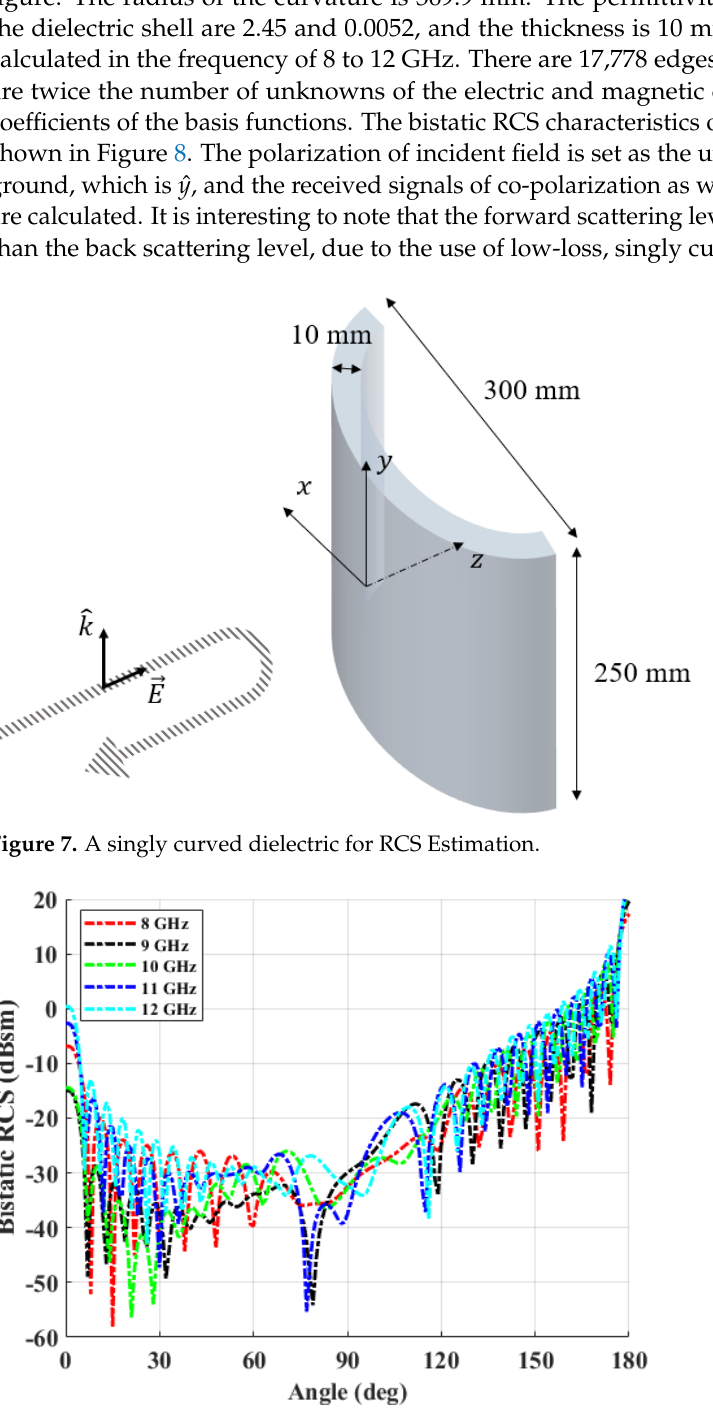
Figure 8. Bistatic RCS of singly curved dielectric